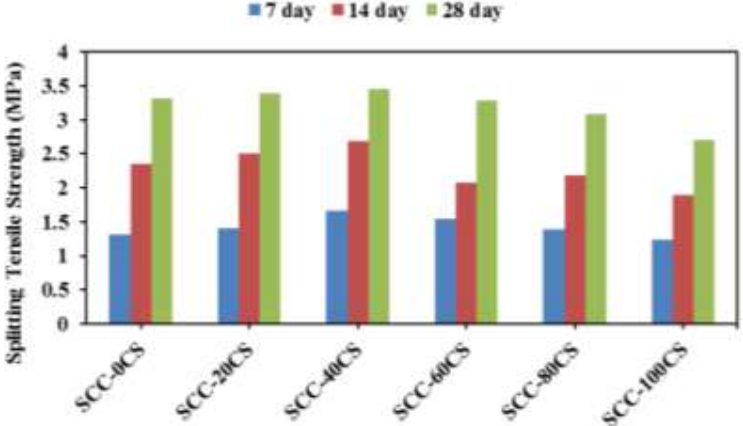
Figure 7. Variation of 7, 14 and 28 day splitting tensile strength for various percentages of copper slag